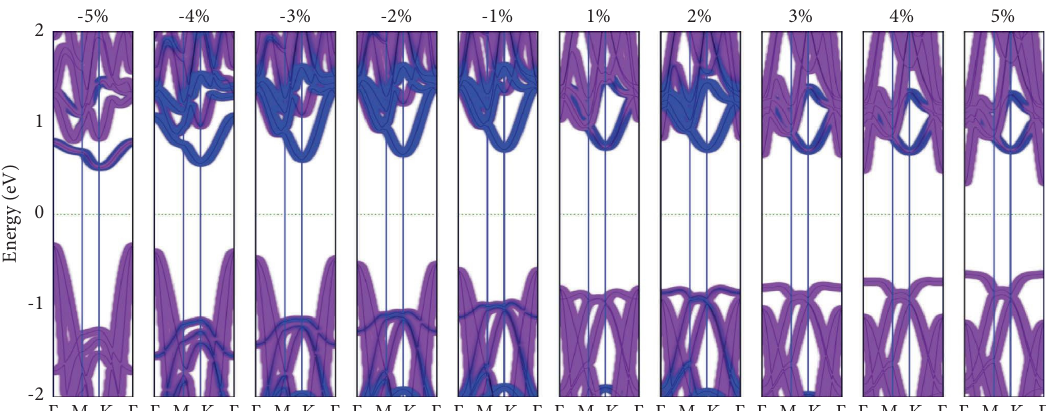
Figure 7: Band structures of the CTF/As vdWhs when applying the axial strain with a 1% step, and the strains are arranged from − 5% to 5% from left to